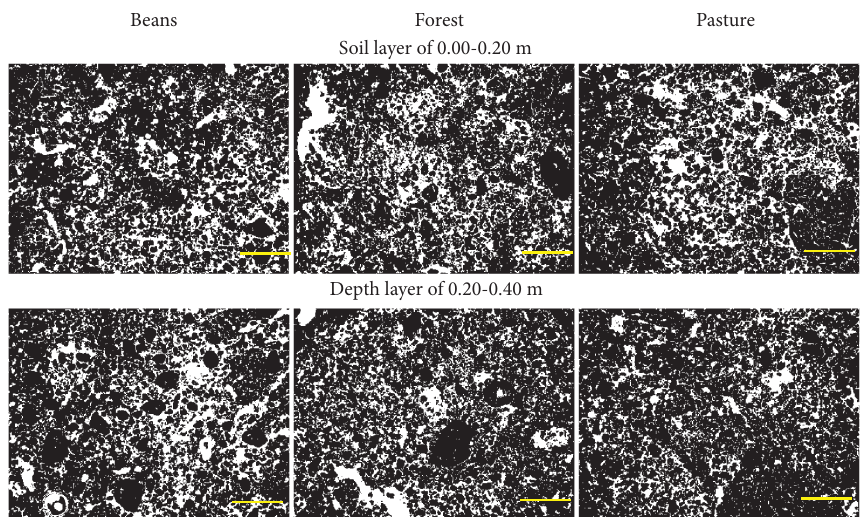
Figure 4: Binary images representing variations in soil structure in areas with pigeon pea, pasture, and native forest in different depth layer ranges (1000 μ m scale in yellow). Colors: black (solid) and white